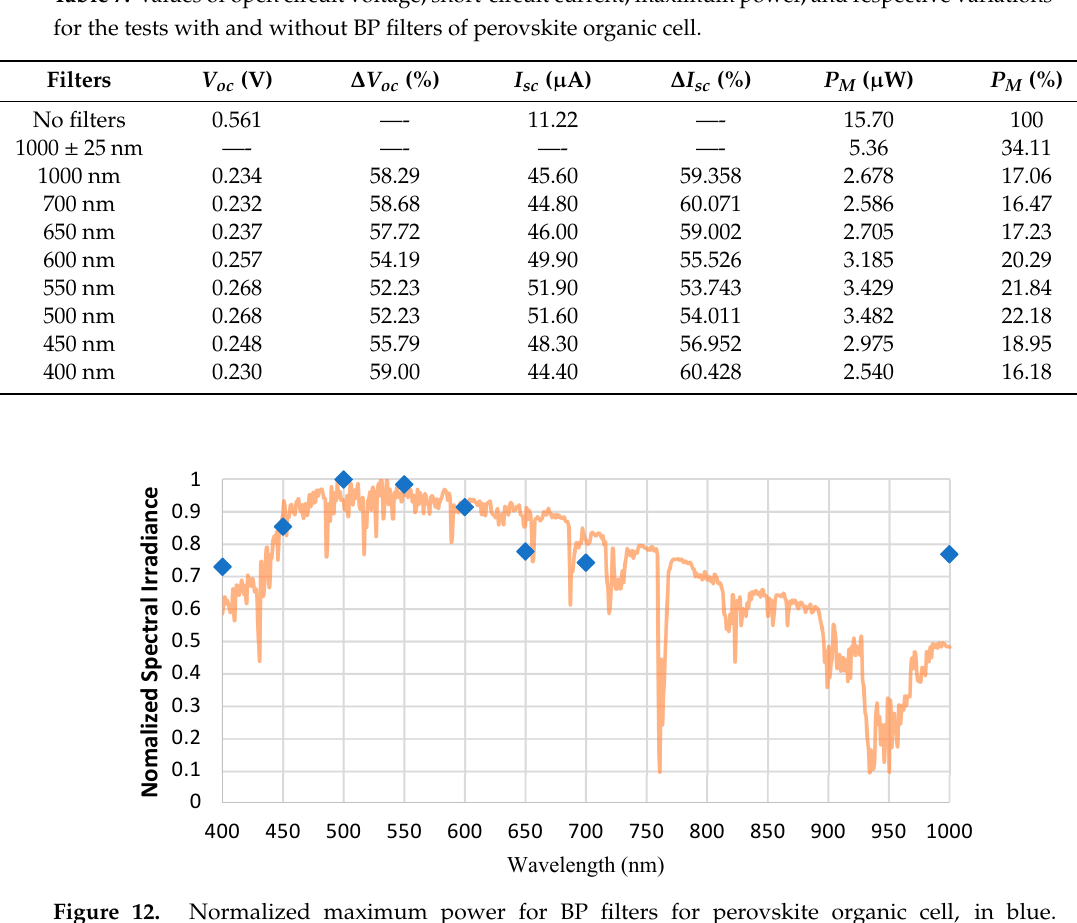
Figure 12. Normalized maximum power for BP filters for perovskite organic cell, in blue. Spectral irradiance normalized, in orange.